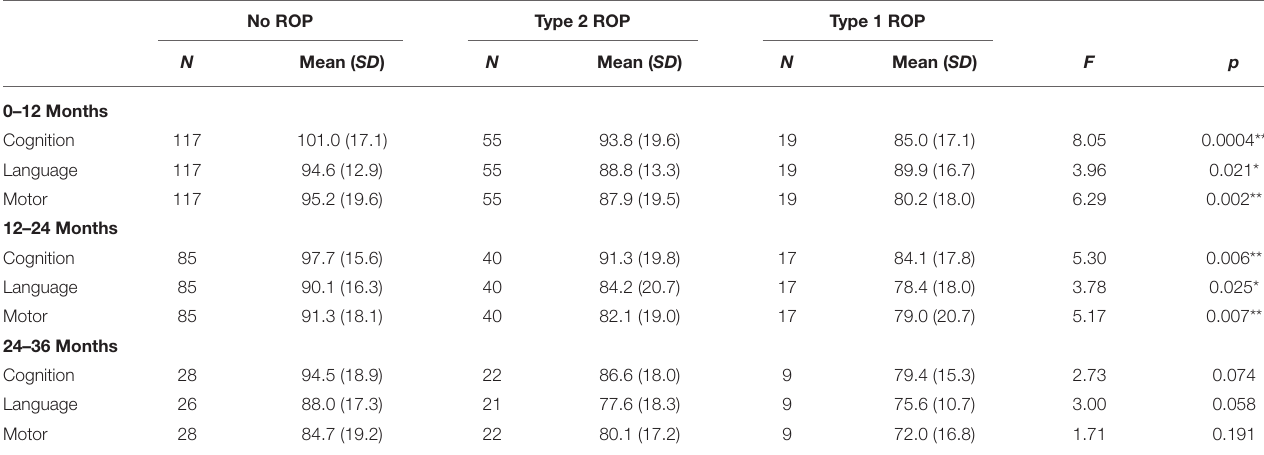
TABLE 3 | Summary of Bayley-III neurodevelopmental scores for infants assessed at 0–12, 12–24, and 24–36